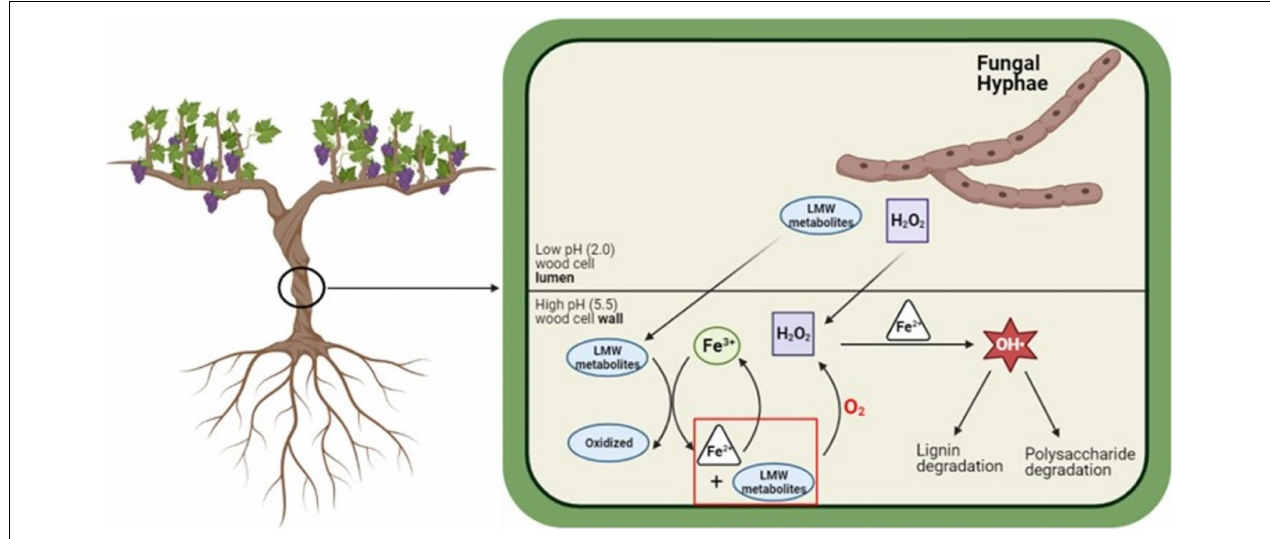
FIGURE 4 | Proposed mechanism for the in situ generation of Fe 2 + and H 2 O 2 , and degradation of lignin and cell wall macromolecules by GTD fungi. LMW metabolites and H 2 O 2 diffuse into the cell wall, where the LMW metabolites sequester Fe 3 + from the cell wall environment and reduce Fe 3 + to Fe 2 + . Through a type of mediated CMF reaction, Fe 2 + and H 2 O 2 react and generate hydroxyl radicals (OH • ). Images built using Biorender software. Schematic modified from Zhu et